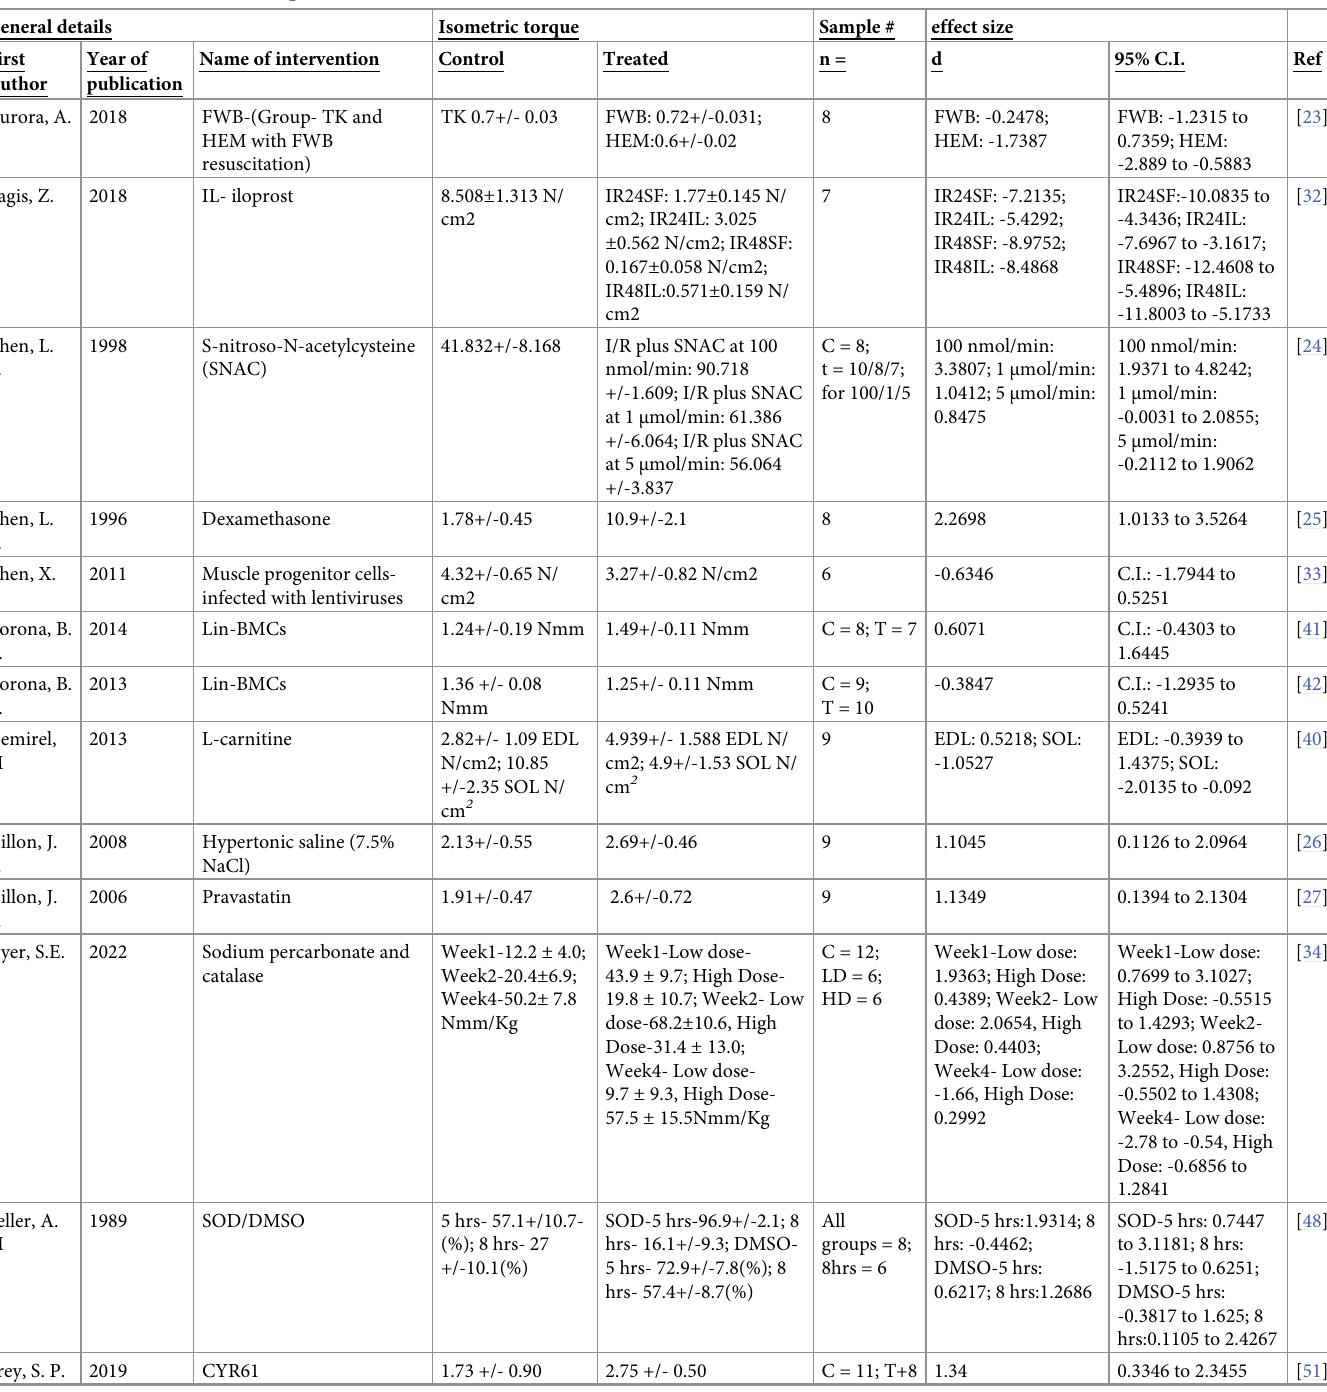
Table 5. Effect sizes of isometric